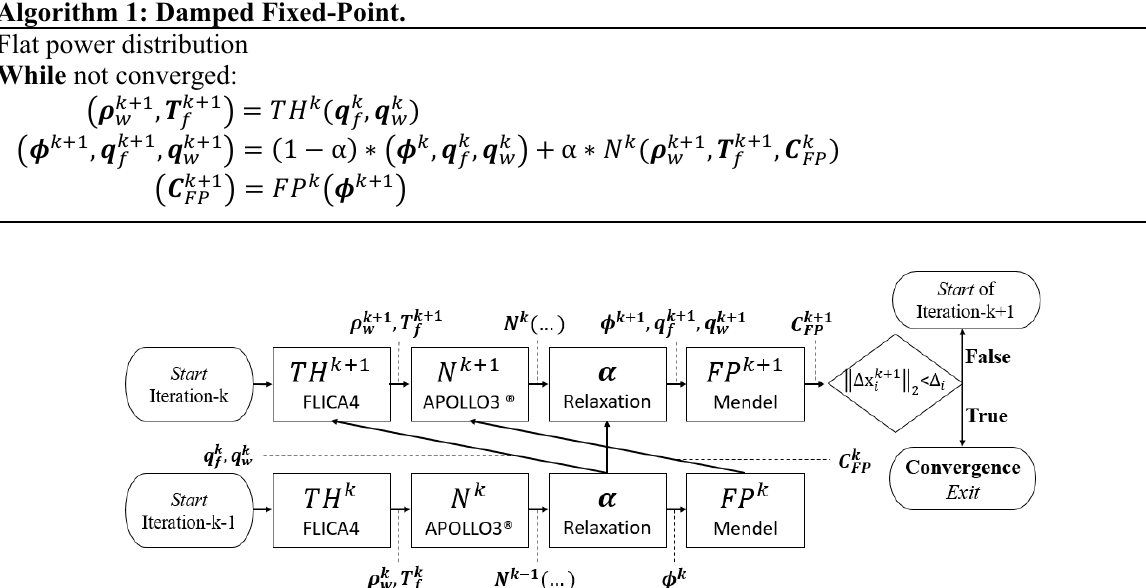
Algorithm 1: Damped Fixed-Point. Flat power distribution